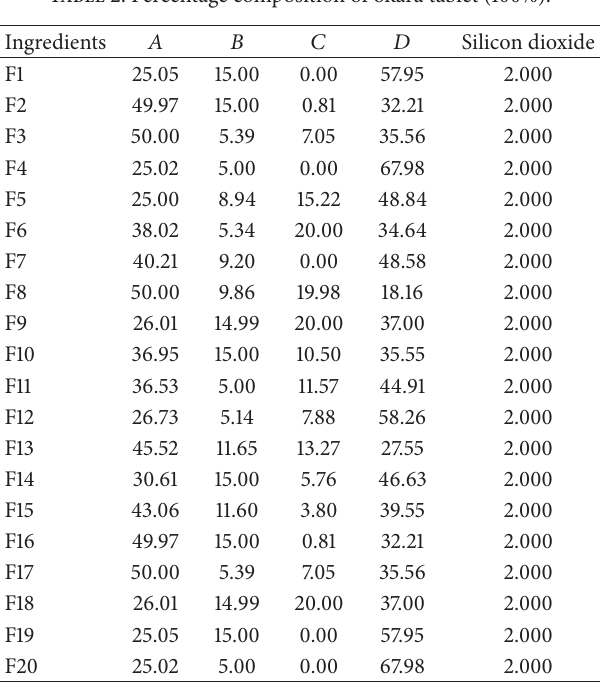
Table 2: Percentage composition of okara tablet